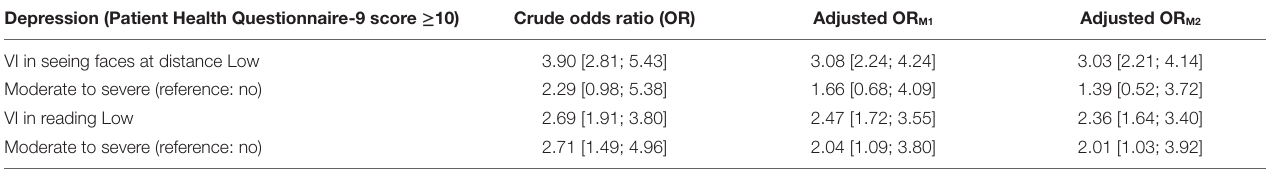
Table 2 | Associations of visual impairment (VI) and depression: results from the DEGS1 study presenting representative data for the German population with an age range from 18 to 79 years ( N = 6.356). Depression (Patient health Questionnaire-9 score ≥